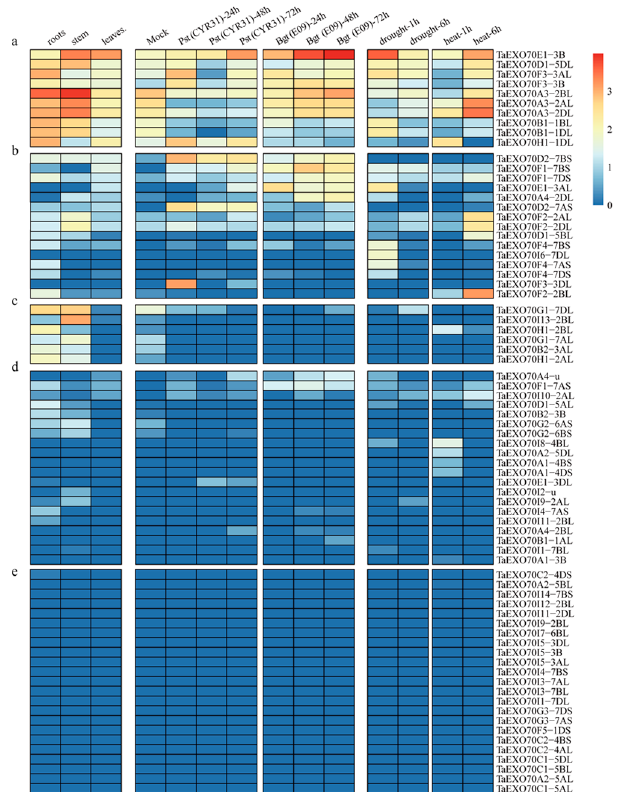
Figure 5. Heat map of the expression profiling of wheat EXO70 genes in different tissues and under various stresses. The color scale bar represents the expression values of the genes. ( a – e ): Genes with different expression types. Abbreviations: Bgt , powdery mildew; Pst : Stripe rust.